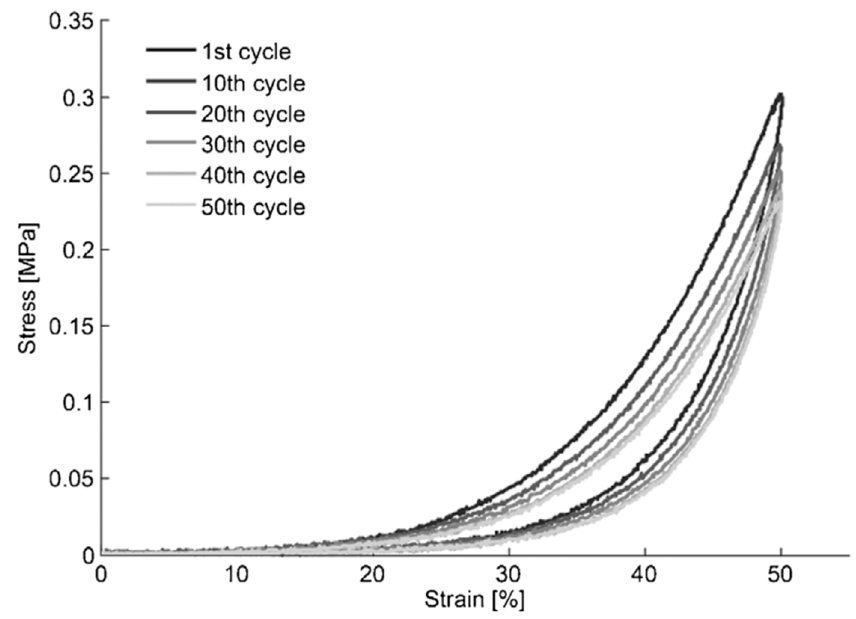
Figure 6. Represents the hysteresis and the load-history dependant behaviour in a one-year-old pig bladder. The cycle numbers are indicated by different shades of grey represented in the figure legend. The peak stress and the figure shapes stabilised after 50 cycles. Figure obtained with permission from [44].